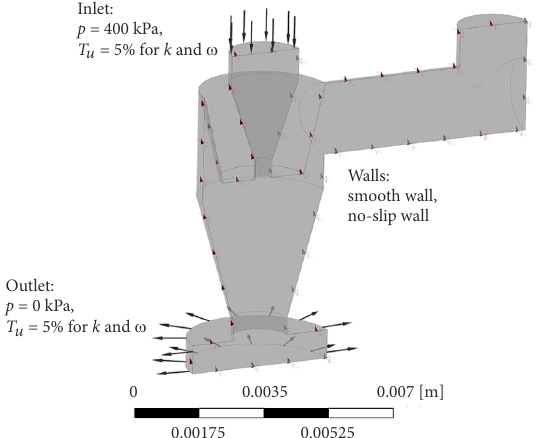
Figure 10. Airflow model limits of the antenna